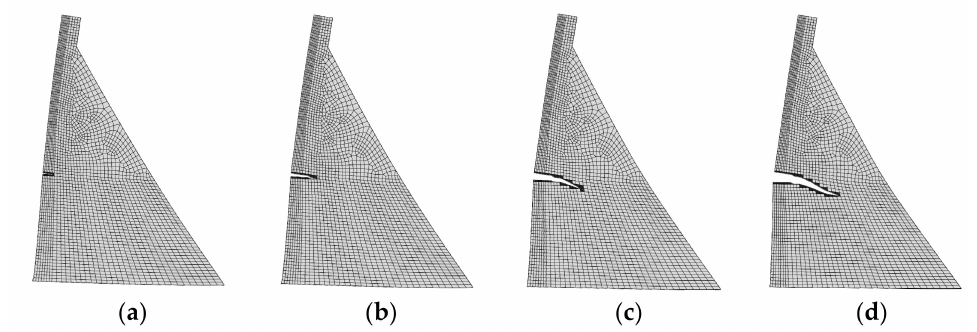
Figure 17. Interlayer joint expansion located at 120 m elevation (magnified by 500 times). ( a ) Initial cracking state; ( b ) 49 step; ( c ) 148 step and ( d ) 181